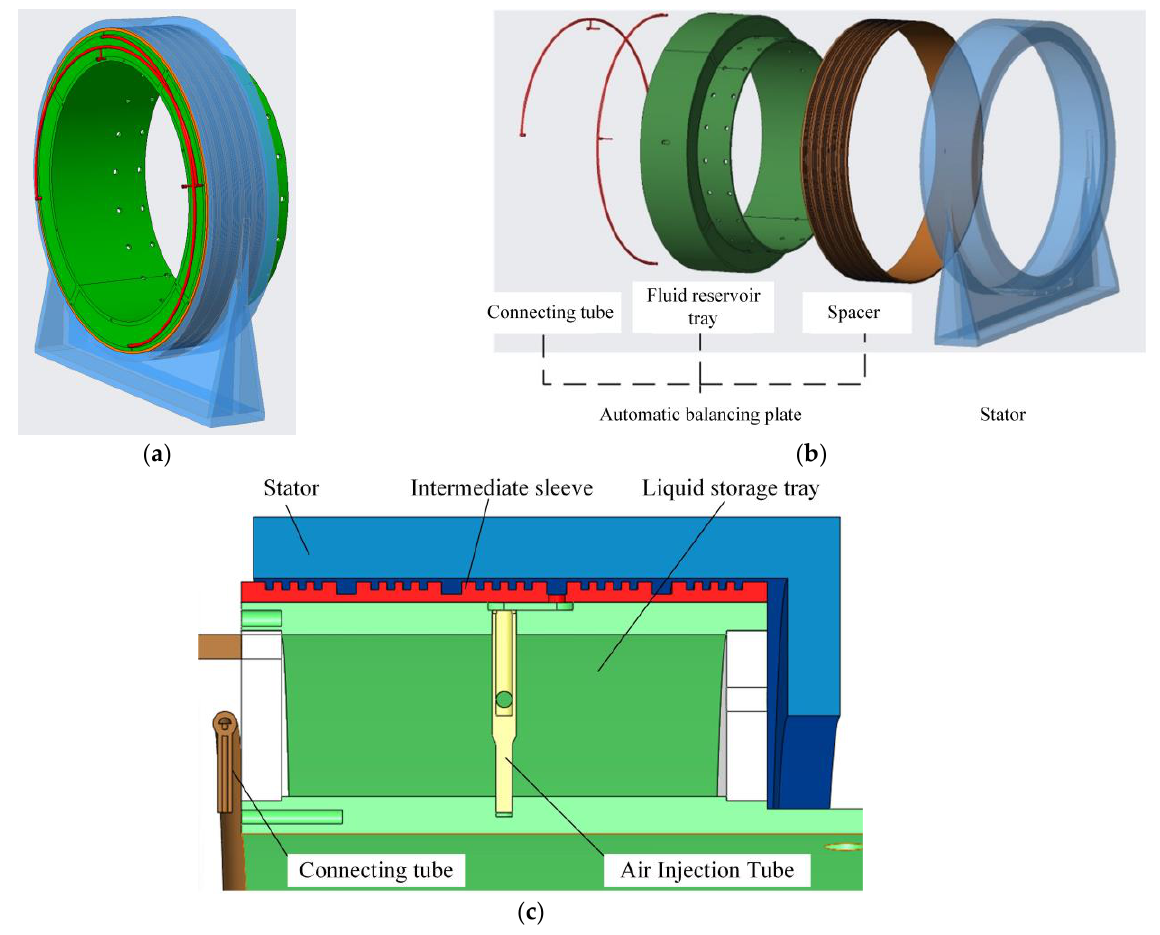
Figure 2. Actuator structure. ( a ) Pneumatic – liquid automatic balance system. ( b ) Exploded view of actuator. ( c ) Schematic diagram of the assembly relationship of each part of the actuator.